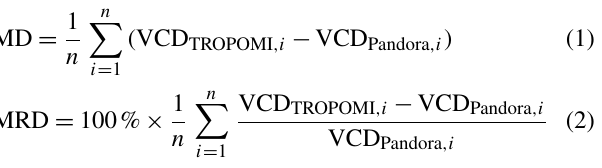
the TROPOMI and Pandora VCDs in Eq. (1), whereas the MRD is the average of these differences when normalised with Pandora’s VCD (Eq.